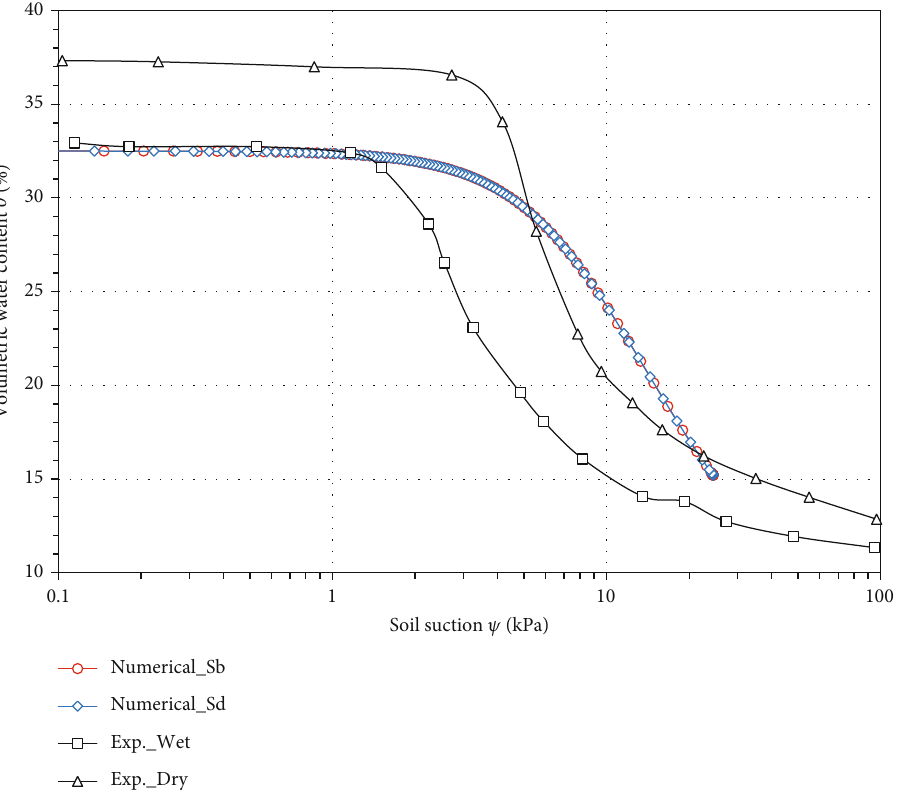
Figure 3: Model calibration by comparing SWCCs of Edosaki sand from experimental and simulation